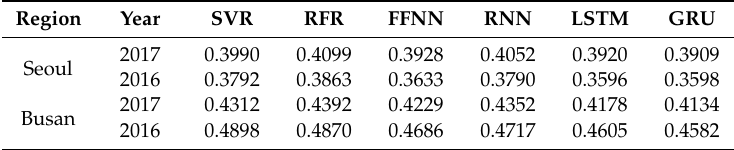
Figure 10. Geographical difference of the two selected regions.